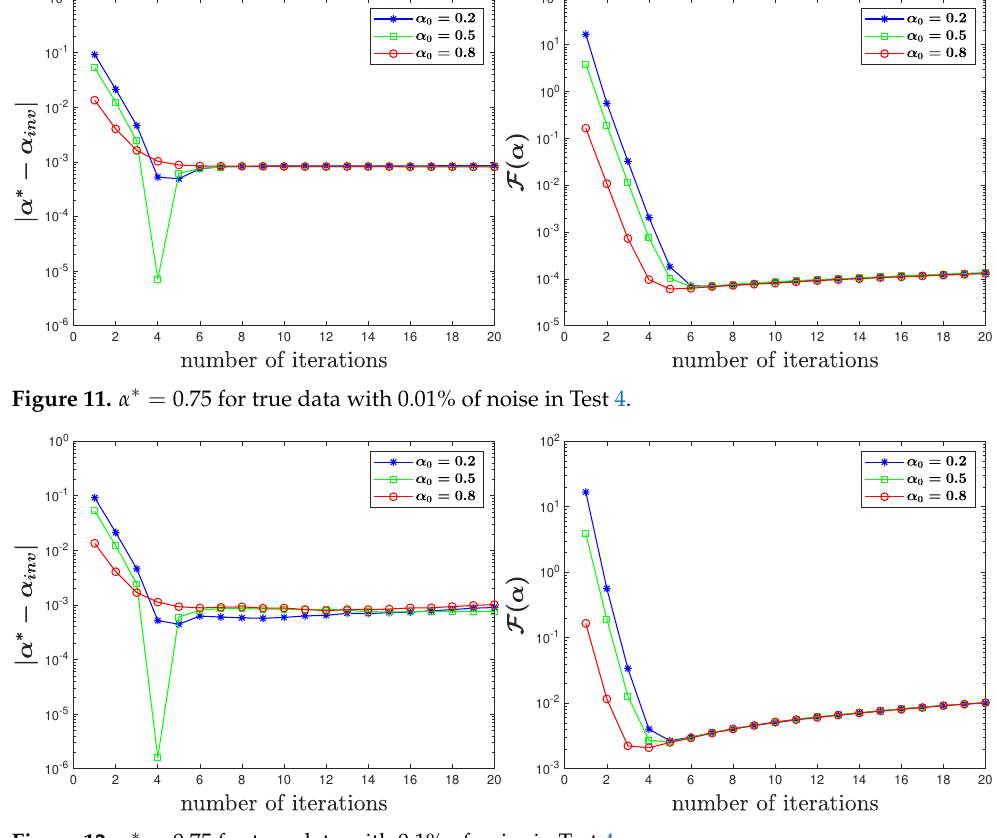
Figure 12. α ∗ = 0.75 for true data with 0.1% of noise in Test